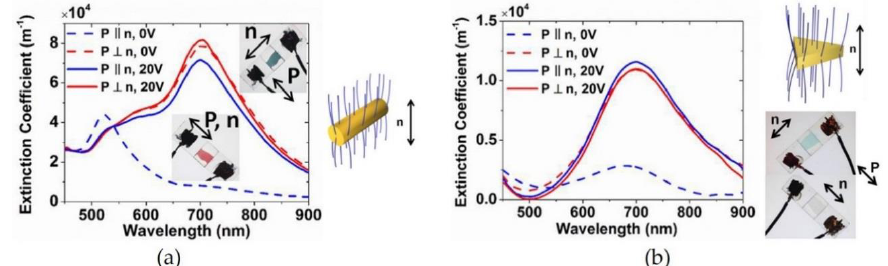
Figure 11. ( a ) Extinction coefficient and color changes of Au nanorods and ( b ) Au nanoplates in liquid crystals (LCs) measured with light at different polarization directions. Reproduced with permission from Reference [77] (Copyright 2015 American Chemical Society).